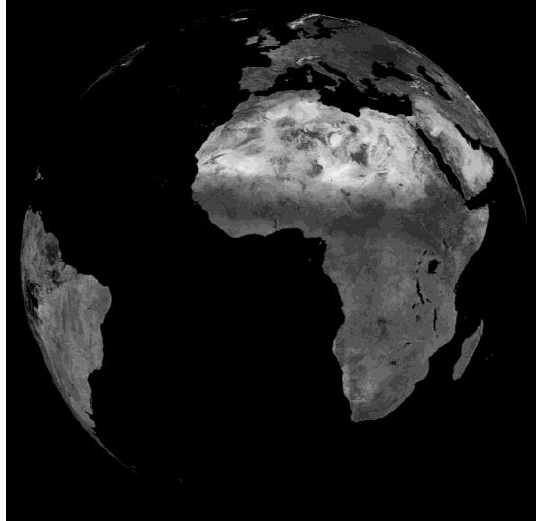
Figure 12. Synthetic SEVIRI image build with MERIS L3 Band 7 data (more than 50